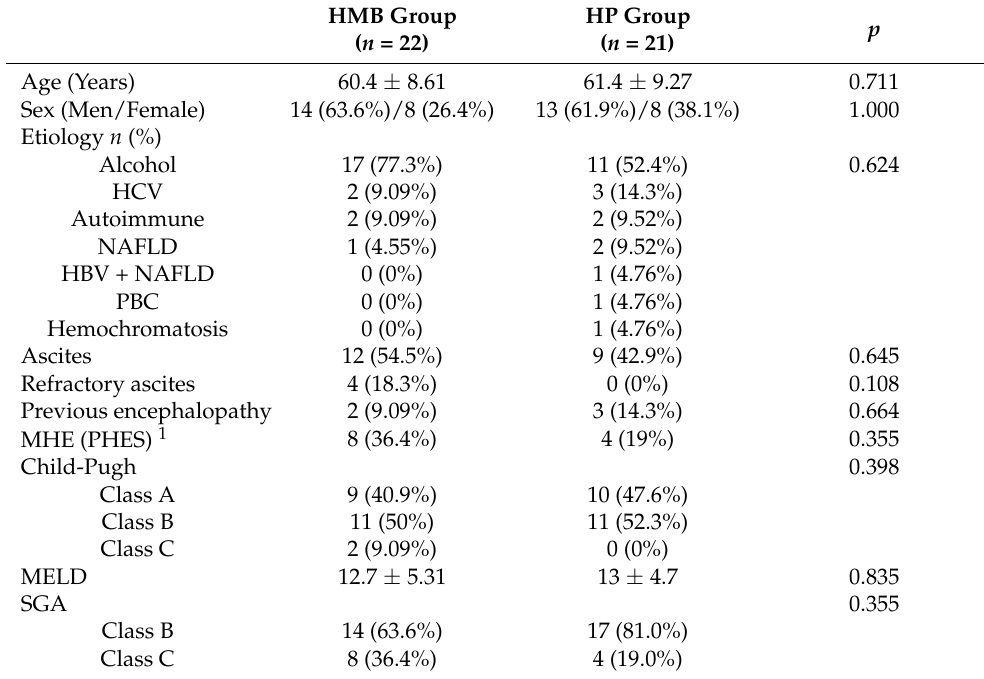
Table 1. Demographics and baseline